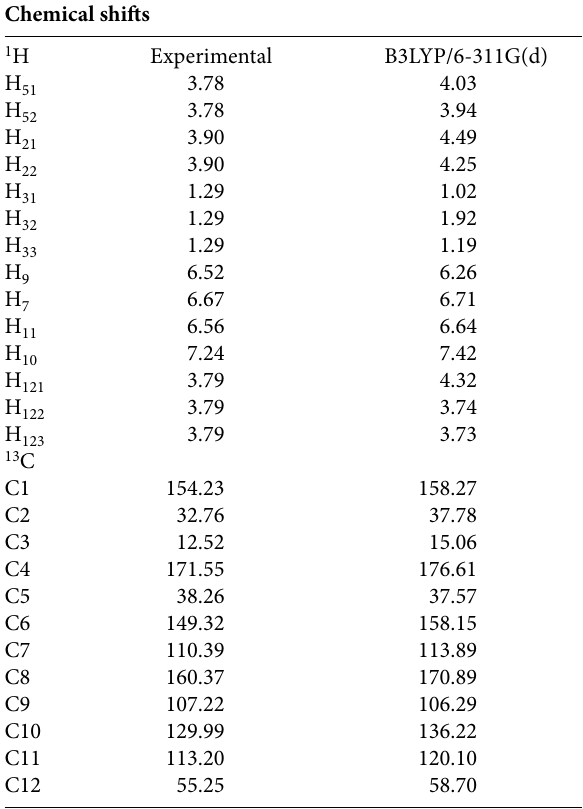
Table 7. Experimental and calculated 1 H and 13 C NMR data for ( Z )- 3- N -(ethyl)-2- N ’-((3-methoxyphenyl)imino)thiazolidine-4-one. Chemical shifts 1 H